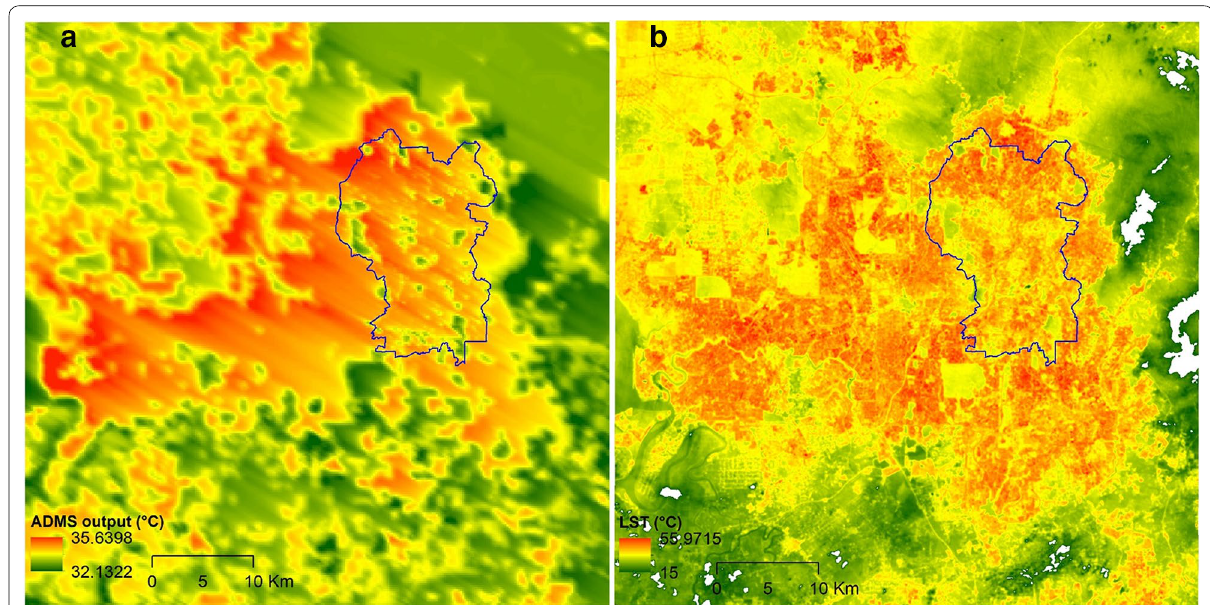
Fig. 3 a ADMS‑Urban modelled air temperatures at 3 m above ground (12:00 noon) and b derived LSTs (11:27 a.m.) for the Greater Kuala Lumpur, blanks are areas with derived LSTs lower than 15 °C due to cloud